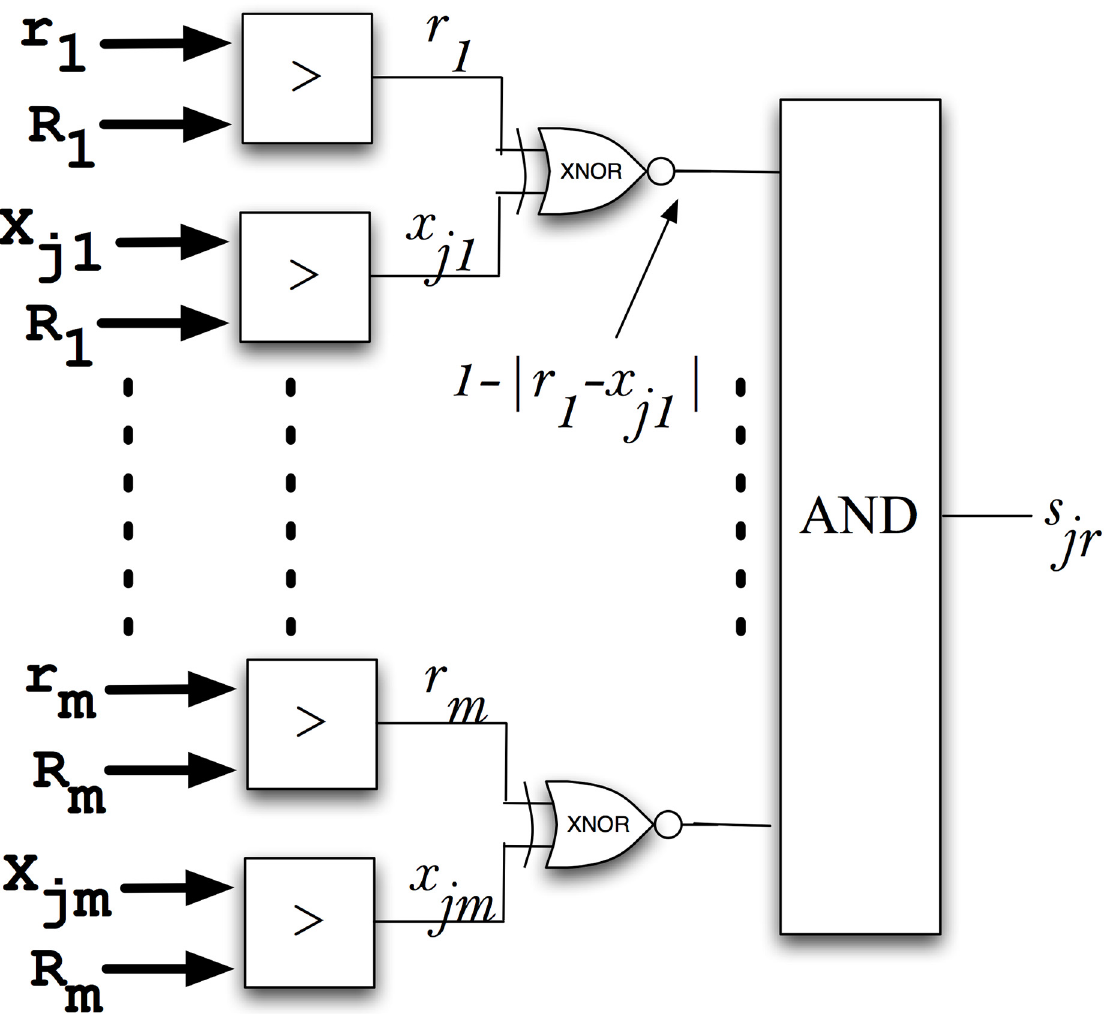
Fig 6. Stochastic architecture for comparing m-dimensional vectors. A total of 'm' random signals are needed for each comparison.